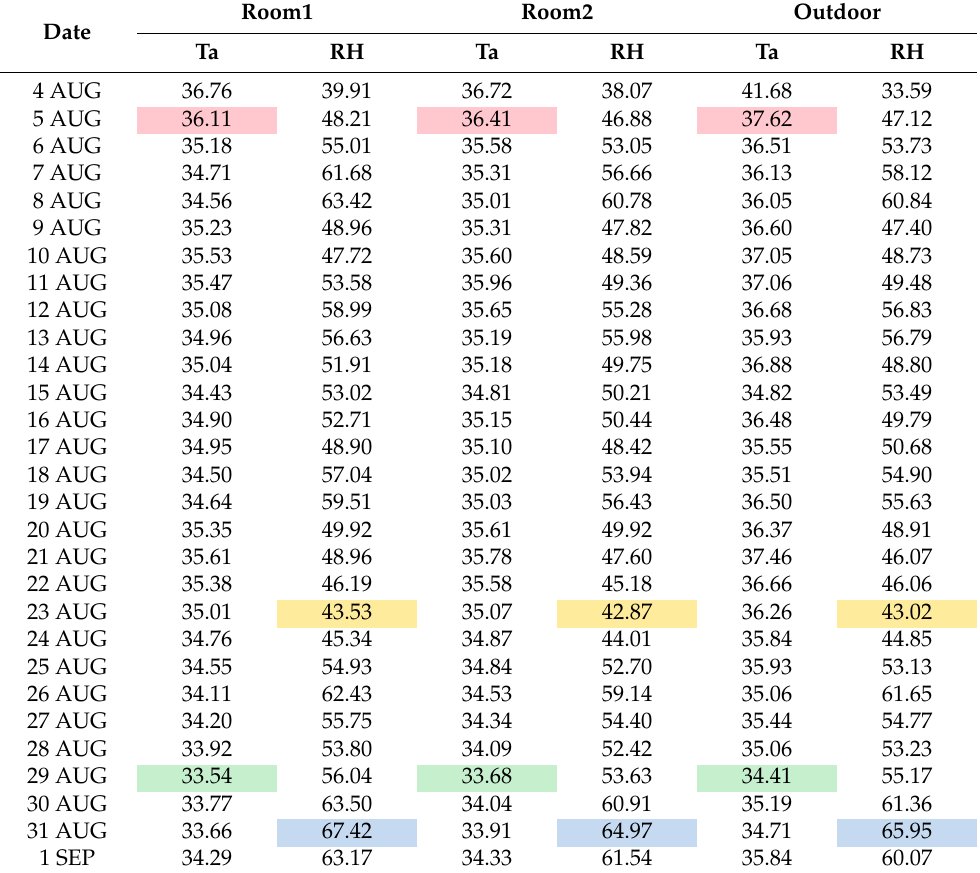
Table 5. Daily average air temperature (Ta) and relative humidity (RH) for the selected